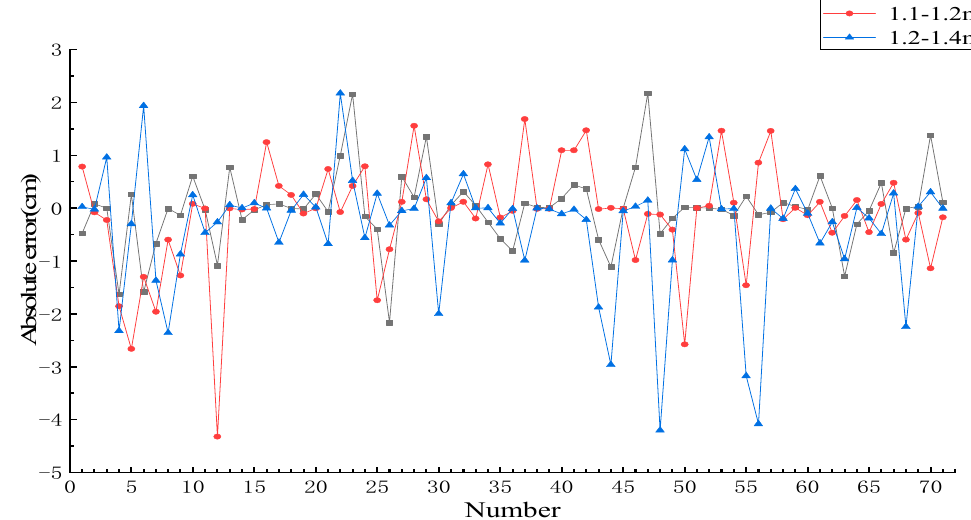
Figure 10. Distribution of absolute errors in different intervals .